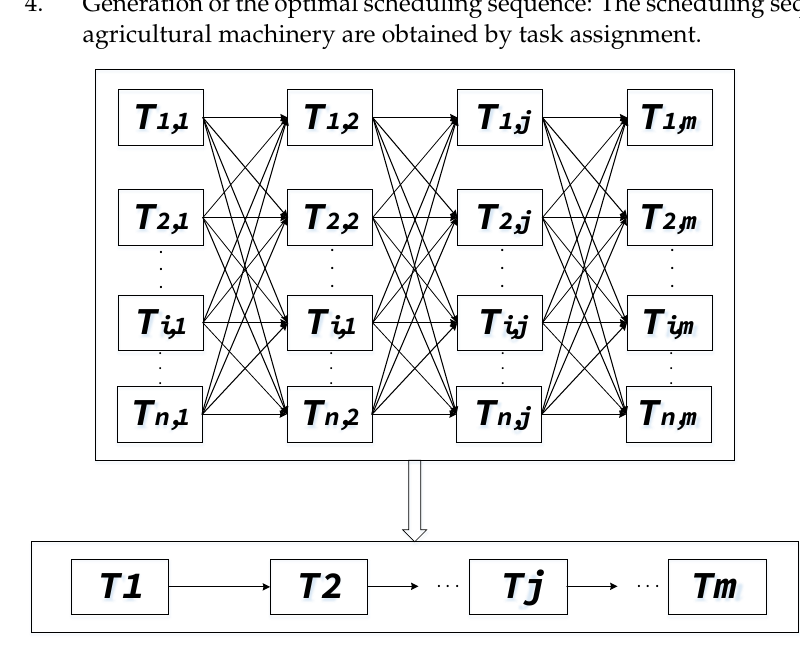
Figure 1. Multitasking composition